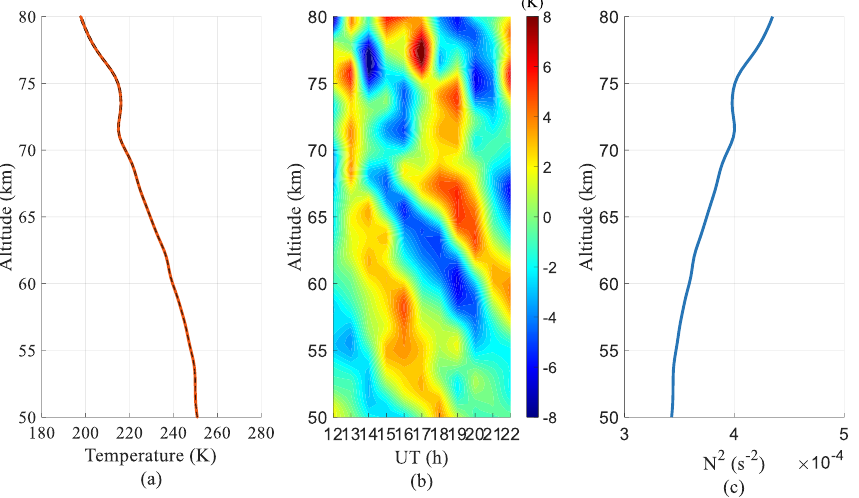
Figure 1. Temperature profile ( a ), temperature perturbation ( b ) and N 2 profile ( c ) on 27 October